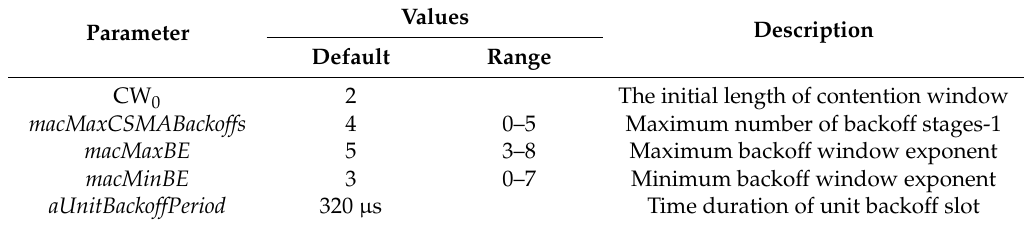
Table 1. Carrier sense multiple access with collision avoidance (CSMA/CA) parameters and values